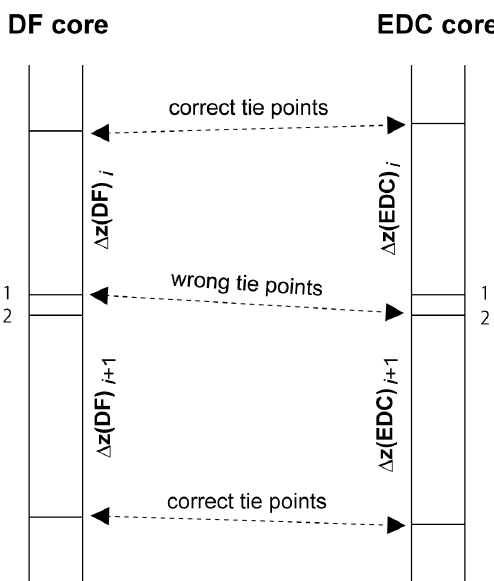
Figure B2. Schematic illustration of choosing the wrong tie points by an operator of the PC interface. The error can occur under con- ditions described below. (i) The volcanic signal 1 in the DF core and the volcanic signal 2 in the EDC core must be significantly ob- servable. (ii) At the same time, the volcanic signal 1 in the EDC core and the volcanic signal 2 in the DF core must be faint or ab- sent. (iii) These two peaks should be within depths of ∼ 0.1m or so of the location expected assuming the layer thickness ratio between the adjacent volcanic match pairs remains constant. Otherwise, the observer will not think that two peak signals are candidates for a true